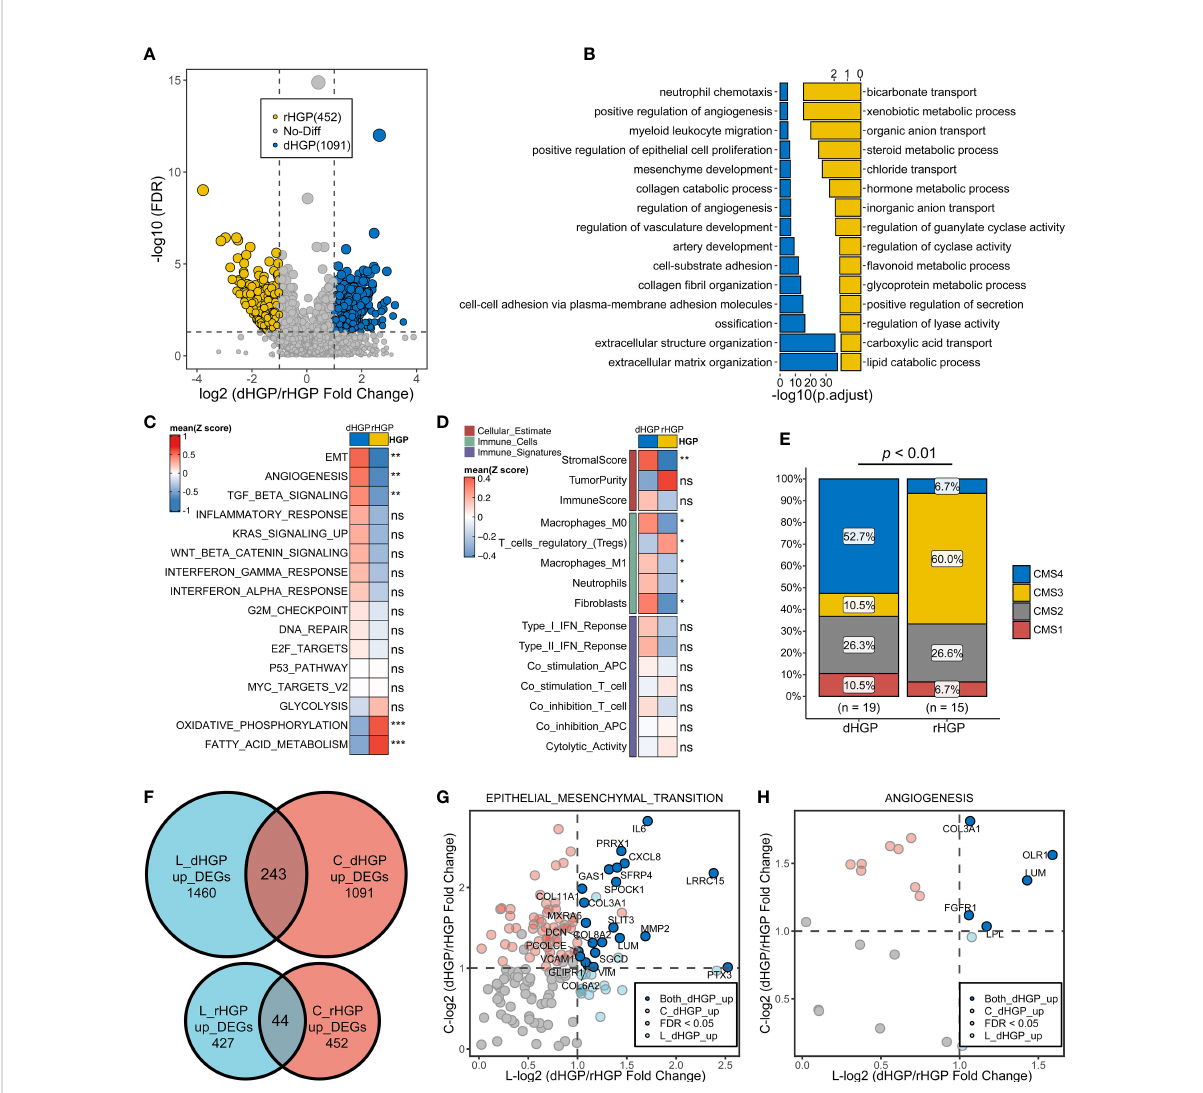
FIGURE 3 Comparison of the transcriptome landscapes of primary lesions between 20 dHGP and 15 rHGP patients. (A) Volcano plot displaying 1091 up- regulated DEGs in the dHGP subgroup and up-regulated 452 DEGs in the rHGP subgroup (|LogFC| > 1, FDR < 0·05). (B) GO-BP enrichment analysis of the differentially expressed genes. (C) Heatmap depicting the differences of HALLMARK pathways activity between dHGP and rHGP subgroups (Wilcoxon test. ns, p > 0·05; ** p < 0·01; *** p < 0·001). Rows represent the mean GSVA scores of HALLMARK pathways, and columns represent HGP subgroups. (D) Heatmap depicting the differences between two subgroups in TIME-relevant molecular signatures were linked to cellular estimates, immune cells and immune signatures (Wilcoxon test. ns, p > 0·05; ** p < 0·01). Rows represent mean ssgsea scores of TIME- relevant molecular signatures, and columns represent HGP subgroups. (E) Proportion of different CMS subtypes of primary lesions in dHGP or rHGP subgroups (Chi-square test, p < 0·01). (F) Venn diagram illustrating the intersection of DEGs in dHGP and rHGP subgroups respectively between the primary lesions and liver metastases. (G) Volcano plot showing the common up-regulated DEGs in the EMT pathways in the dHGP subgroup between primary lesions and liver metastases. (H) Volcano plot showing the intersection of DEGs up-regulated in angiogenesis pathway in the dHGP subgroup between primary lesions and liver metastases. *p <